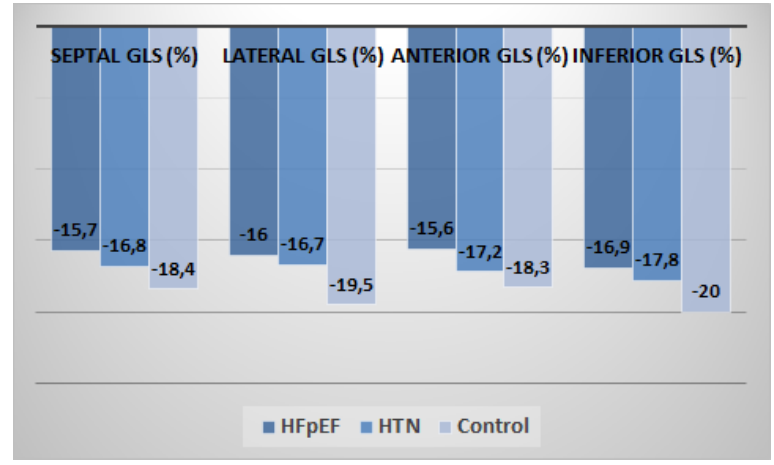
Figure 4. Distribution of mean regional longitudinal strain values at basal level between the three groups ( n = 148).